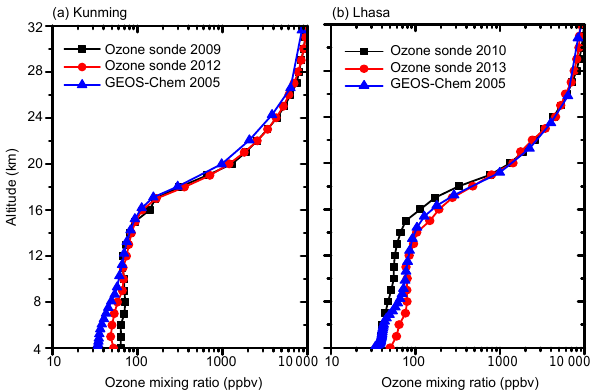
Figure 6. The simulated and observed vertical profiles of monthly mean O 3 mixing ratios at (a) Kunming and (b) Lhasa in